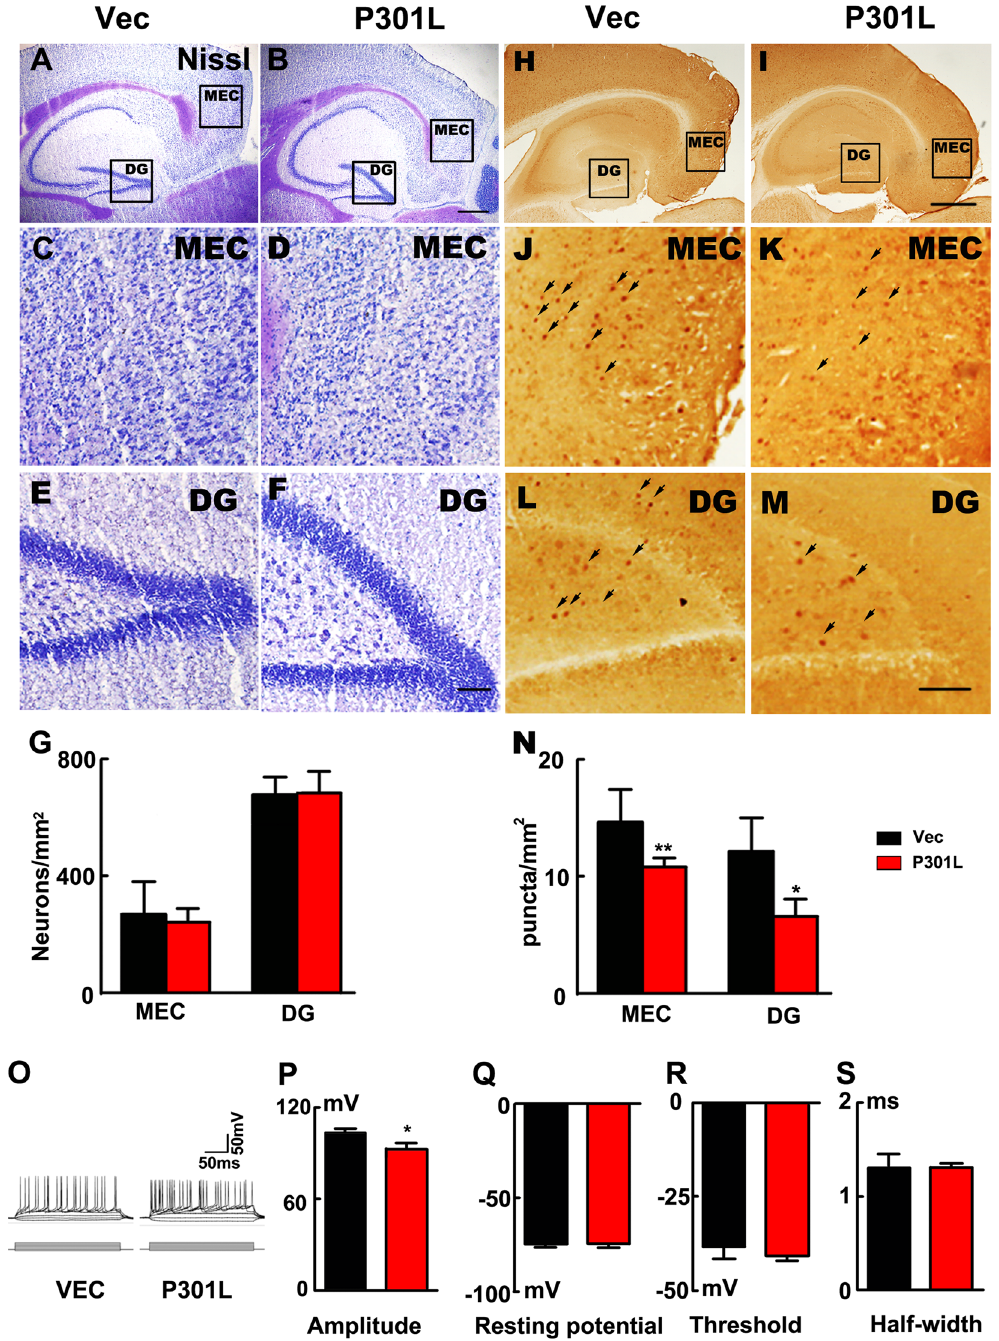
Figure 4. Expression of P301L hTau in MEC suppresses the neuronal activity without causing significant cell death. ( A – F ) Nissl staining indicated that the numbers of neurons were not changed in P301L hTau transduced mice in both MEC and DG regions compared to control (scale bar in A and B, 500 μ m; in C-F, 100 μ m). ( G ) Quantitative analysis of the Nissl staining showed that P301L hTau transduction didn’t lead to neuronal death (n = 3 per group). ( H – M ) c-fos was employed to detect the neuronal activity. A density of the c-fos puncta in both MEC and DG subsets was remarkably decreased in P301L hTau-transduced mice compared with the control. (scale bar in H and I, 500 μ m; in J-M, 100 μ m). ( N ) Quantification of the number of c-fos positive cells per 1 mm 2 revealed that P301L hTau lowered the c-fos expression in the MEC and DG. (n = 3 per group, 9 slices, * p < 0.05, ** p < 0.01). ( O – S ) Whole-cell patch results suggested that AP amplitude was significantly lowered in P301L hTau cells compared to control ( O , P ). However, passive properties were not altered in P301L hTau cells since their membrane resting potential ( Q ) was unchanged compared to controls. There was no difference in threshold ( R ) or half width (duration, ( S )) between control and P301L hTau cells (n = 3 per group, 9 slices, * p < 0.05). Arrows in J-M were used to indicate the cFos staining. Data were expressed as mean ±